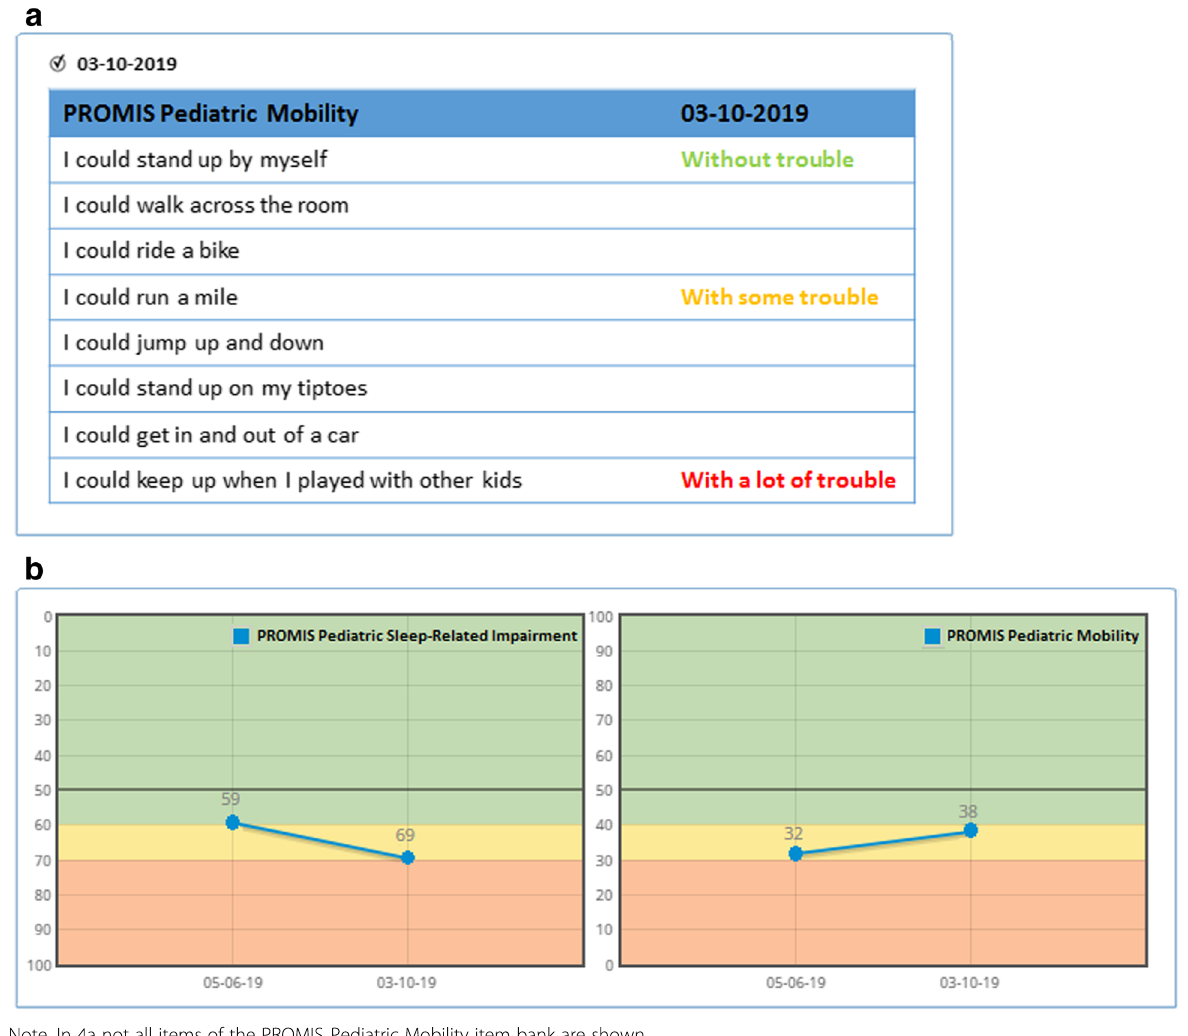
Fig. 4 Preliminary recommended individual item ( 4a ) and domain score ( 4b ) feedback of PROMIS CATs